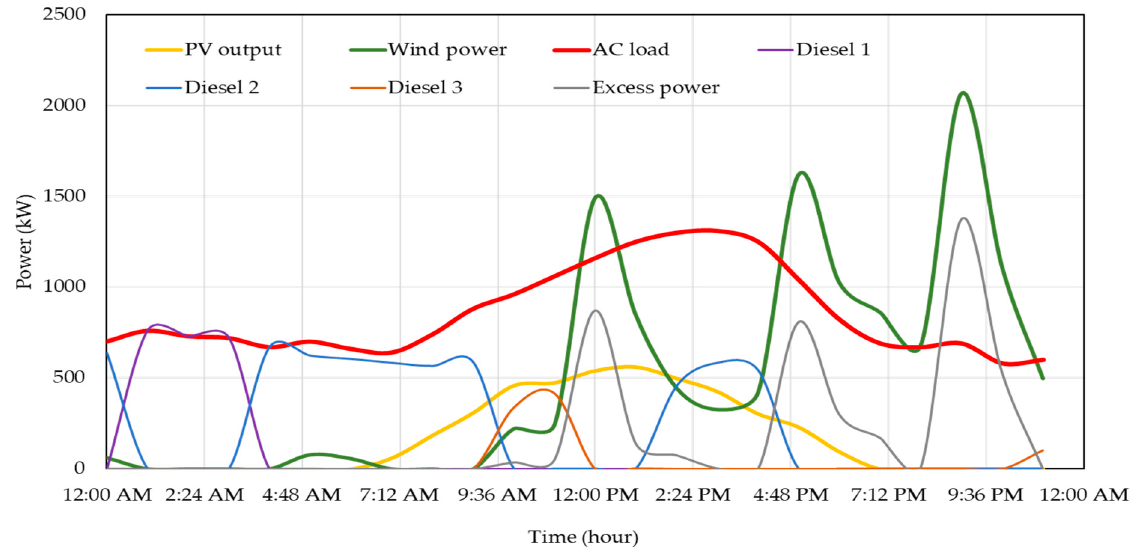
Figure 11. Power balance between the generations and load on a day with peak load (during summer).